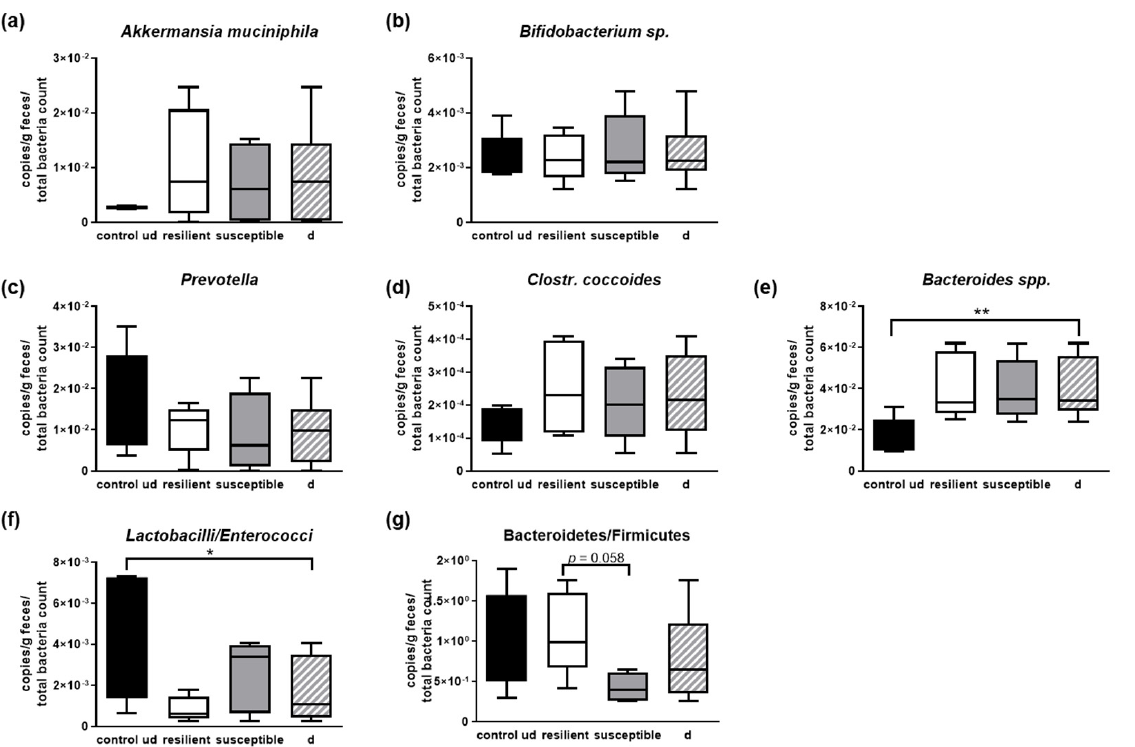
Figure 6. Analysis of microbial composition of feces derived from defeated and undefeated male mice. ( a ) The feces of the five selected animals per group (see Figure 5a) was analyzed in more detail via qPCR regarding representative microbial commensals: ( a ) Akkermansia muciniphila , ( b ) Bifidobacterium sp., ( c ) Bacteroides group, ( d ) Prevotella , ( e ) Clostridium coccoides , ( f ) ratio of Lactobacilli to Enterococci and ( g ) Bacteroidetes–Firmicutes ratio. Data are shown with means and min to max. Statistics were performed using one-way Anova with Fisher’s LSD test (* p < 0.05, ** p < 0.01). None of the comparisons were statistically significant (n = 5 per group; undefeated controls = ud; defeated controls = d (mean of resilient and susceptible, n = 10)).